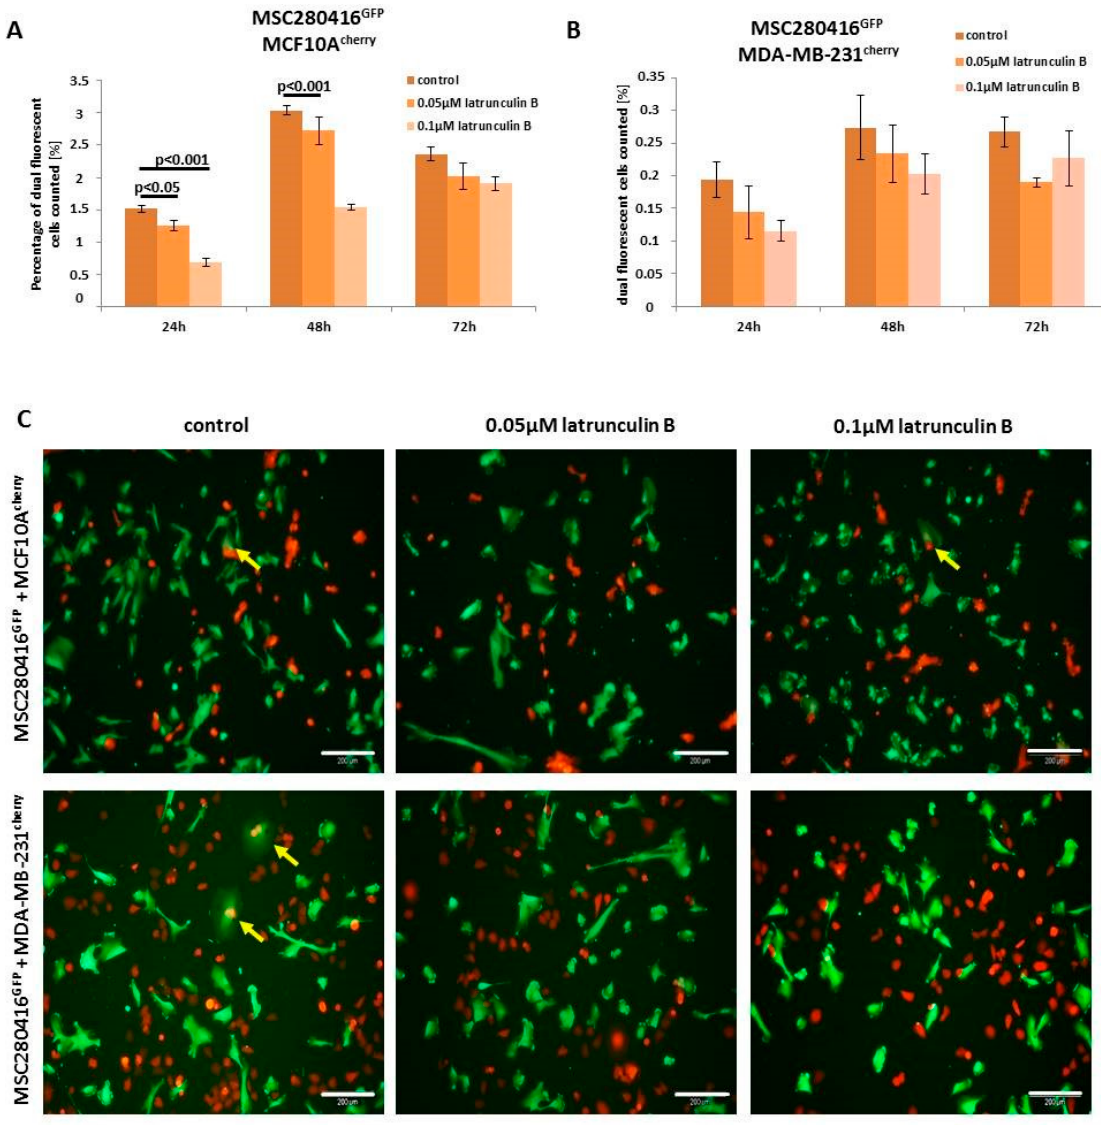
Figure 5. Fusion cell quantification in co-cultures treated with latrunculin B. ( A , B ) Co-cultures of MSC280416 GFP with MCF10A cherry or MDA-MB-231 cherry were treated with 0.05 µ M and 0.1 µ M latrunculin B for 24 h, and hybrid cell formation was calculated by cell counting. Significance ( p ) was calculated by the mean ± SD from triplicates ( n = 3) using ANOVA followed by Dunnett´s multiple comparisons test. ( C ) Fluorescent microscopic images of co-cultures treated with 0.05 µ M and 0.1 µ M latrunculin B were compared to control co-cultures. Bars represent 200 µ